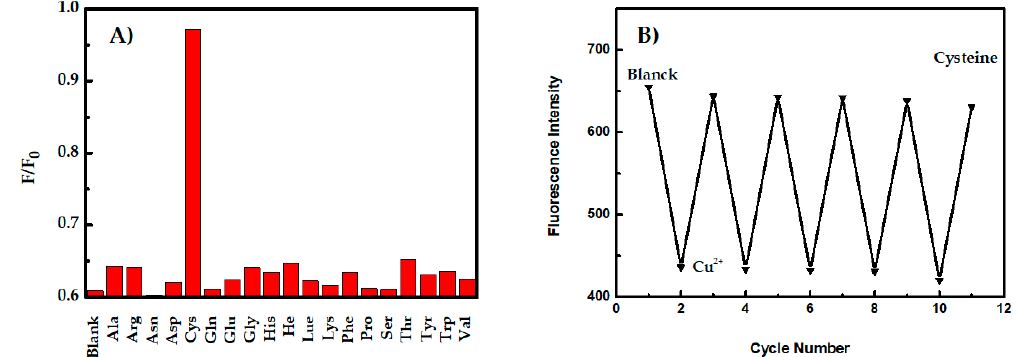
Figure 4. ( A ) Fluorescence changes of AIE dots/Cu 2+ in the presence of different amino acids with a concentration of 5 μ M. ( B ) Fluorescence intensity as a function of the cycle number. The fluorescence intensity of AIE dots after quenching by Cu 2+ (5 μ M) can be recovered by the addition of 2.5 μ M cysteine.